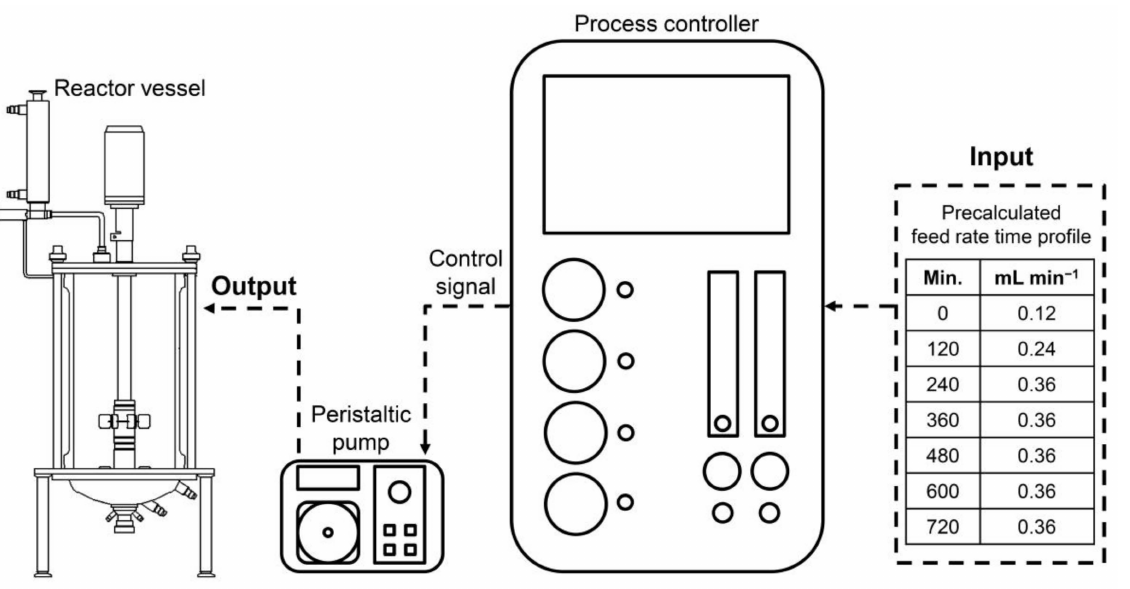
Figure 2. Open-loop feed rate control in a